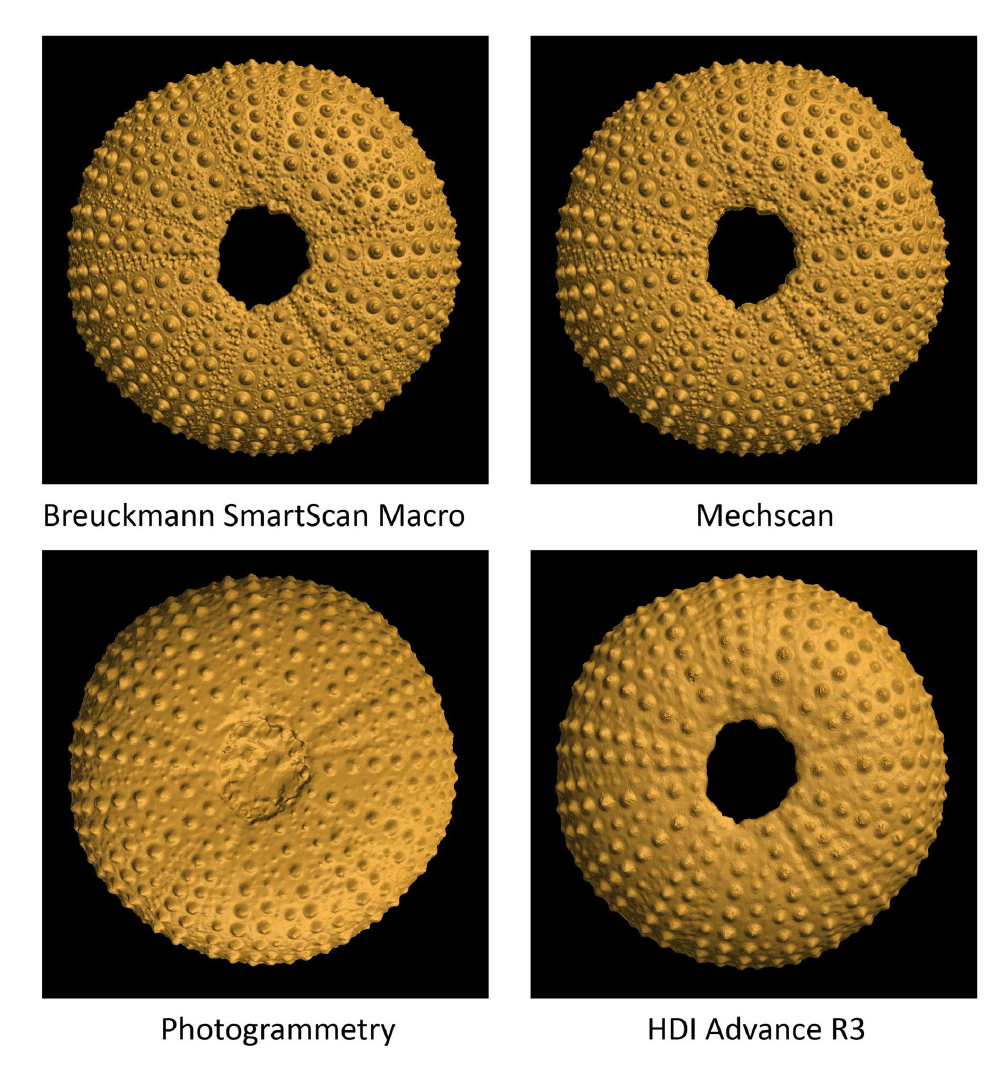
Fig. 6.5. Sea urchin captured by 3 different structured light scanners and by